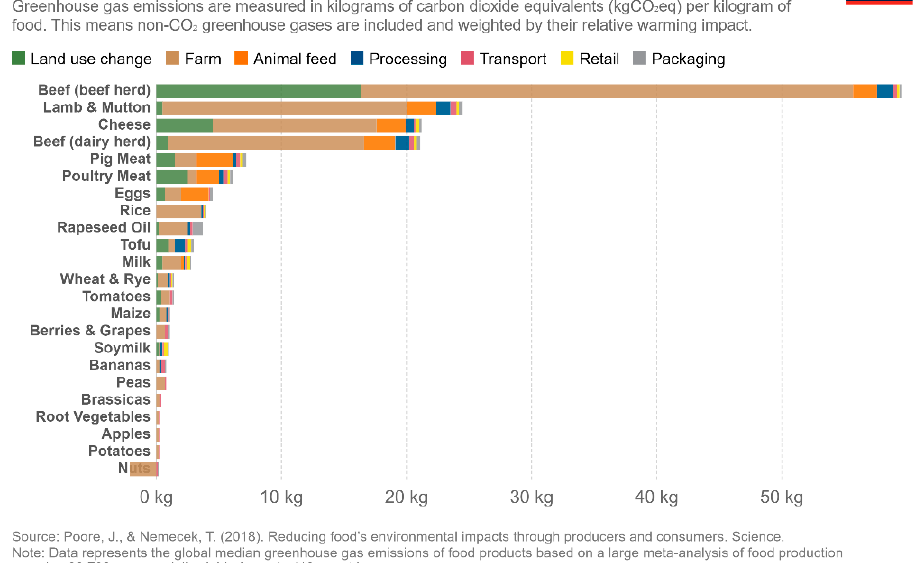
Figure 1. GHG emissions of select foods across the global supply chain. Reproduced by use of OurWorldInData’s CC-BY license, and with permission from Poole, the corresponding author of the original dataset.